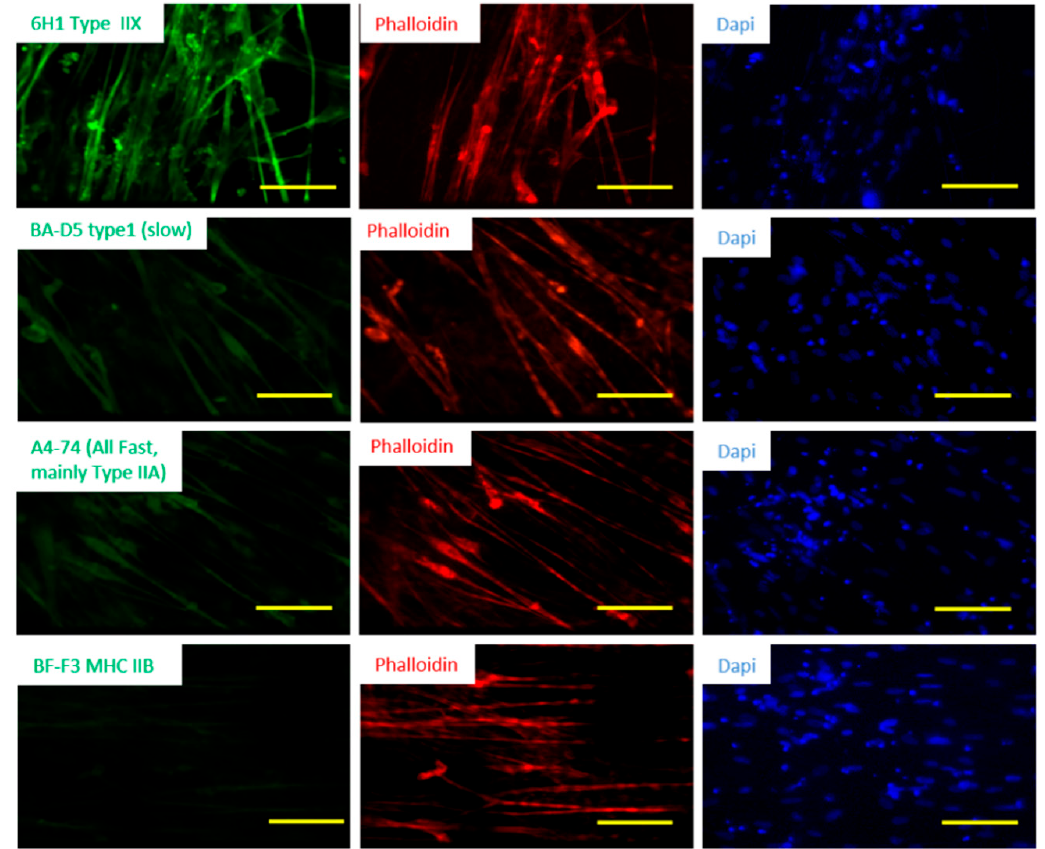
Figure 3. Fiber type characterization of iPSC derived hSKM. The iPSC-hSKM culture after approximately two weeks of di ff erentiation were immunostained with fiber type-specific antibodies which